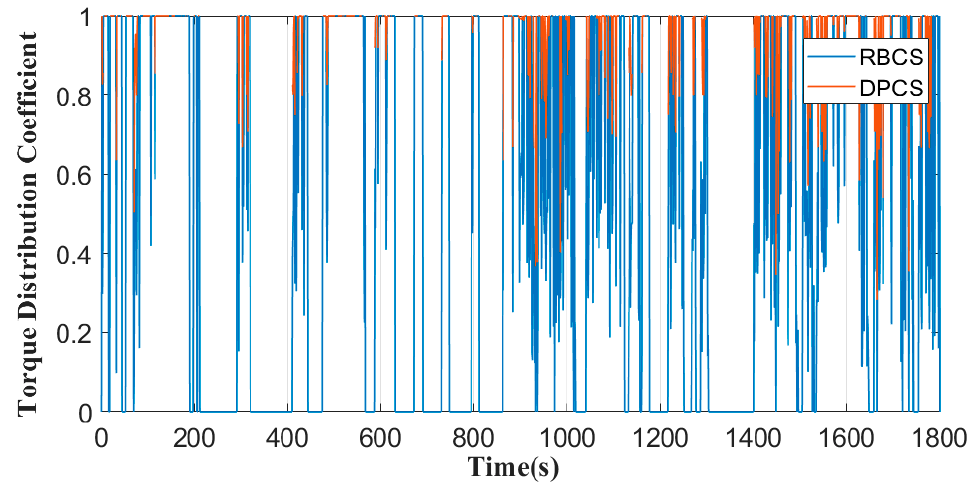
Figure 10. Torque distribution coefficient under different control strategies.